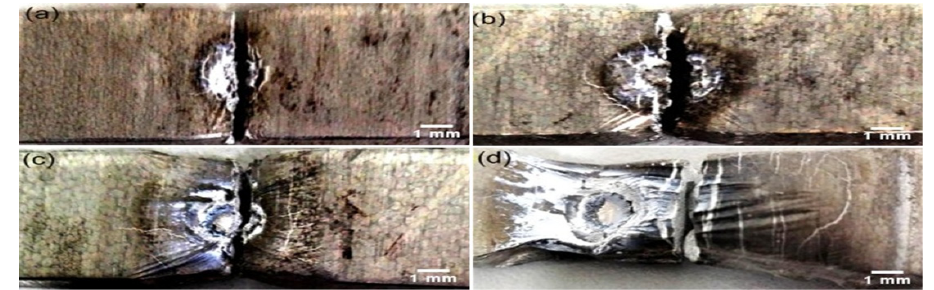
Figure 8. Rupture morphology of the Al-7075 specimens fractured under the conditions of 2.7 kW/cm 2 laser power density and various preloaded speeds of ( a ) 0.5 mm/min; ( b ) 1 mm/min; ( c ) 2 mm/min; ( d ) 4 mm/min.